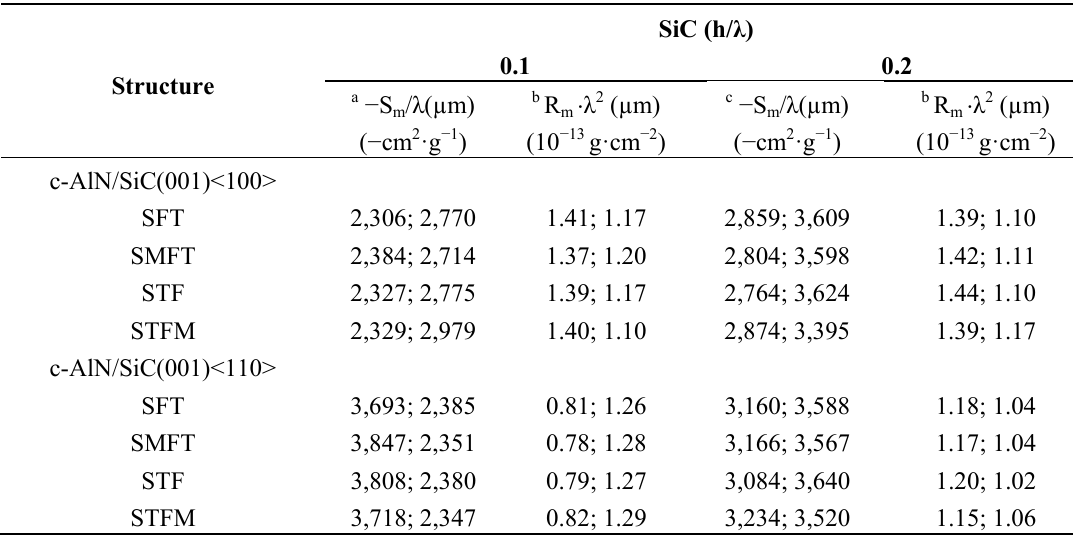
and the limit of mass resolution R m